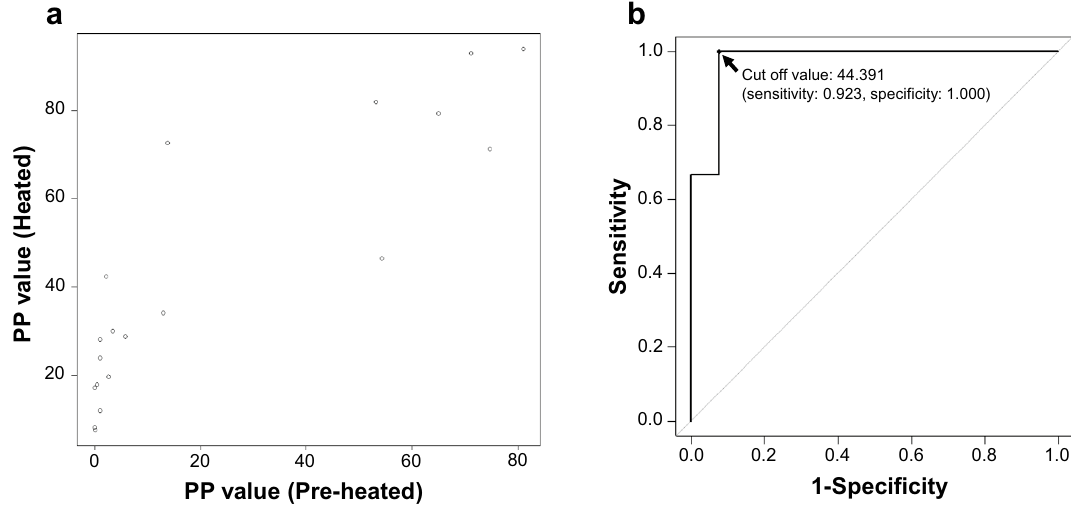
Figure 1. Relationship between the Percentage of Positivity (PP) values from the pre- and post-heated serum samples measured with the ELISA system to detect anti- T. gondii antibodies. ( a ) PP values of the 19 sera from pigs experimentally infected with T. gondii . Each circle represents the data for each wild boar. ( b ) ROC curve used for calculating the cut-off value for the post-heated samples. The curve was created on the assumption that the results from the pre-heated samples are